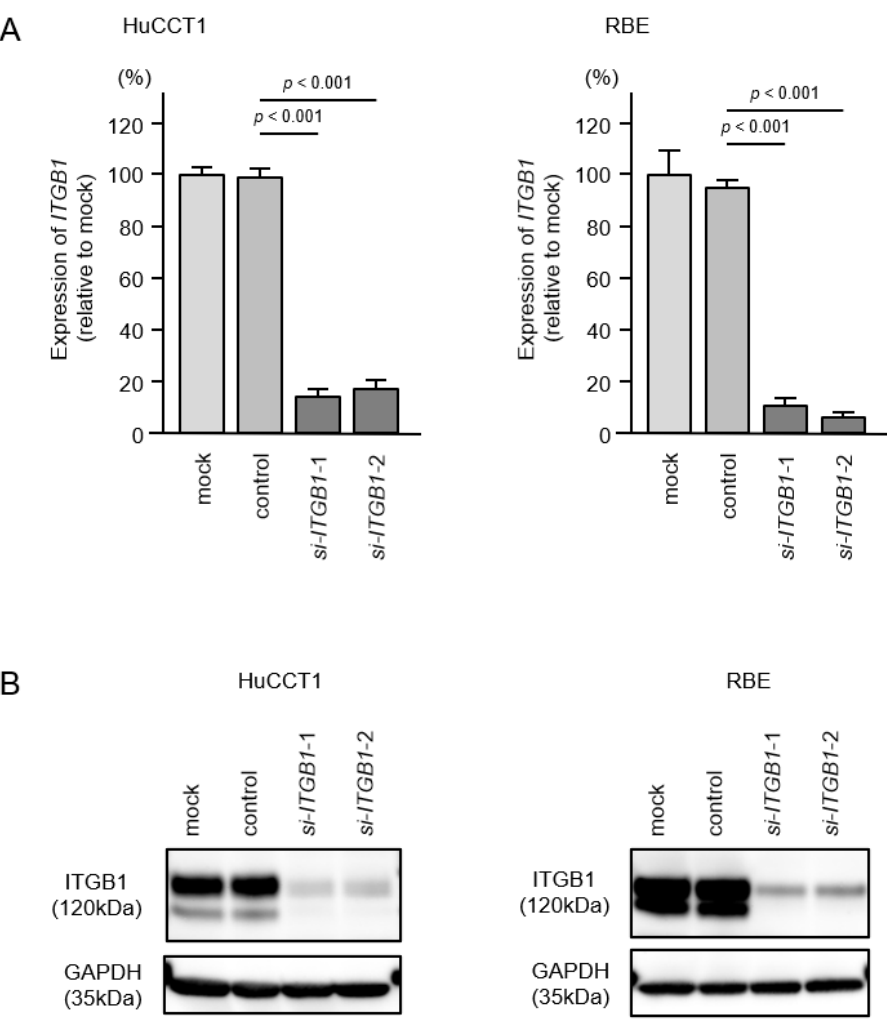
Figure 9. Knockdown efficiency of si ITGB1 in HuCCT1 and RBE cells. ( A ) Expression of ITGB1 in ICC cell lines was evaluated 72 h after transfection with si-ITGB1-1 or si-ITGB1-2 . GUSB was used as an internal control. ( B ) Expression of ITGB1 in intrahepatic cholangiocarcinoma (ICC) cell lines was evaluated by Western blot analysis 72 h after transfection with si-ITGB1-1 and si-ITGB1-2 . GAPDH was used as internal control.